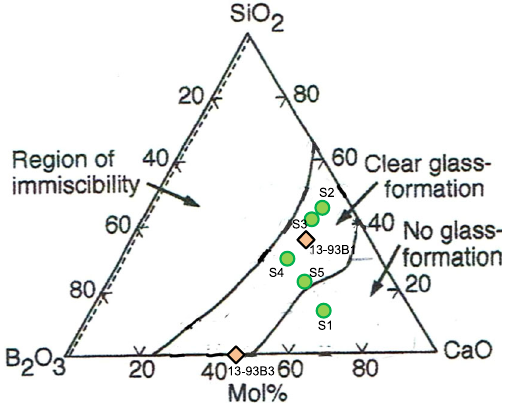
Fig. 1 Compositions of examined glasses, which were plotted in the compositional triangle CaO-B 2 O 3 -SiO 2